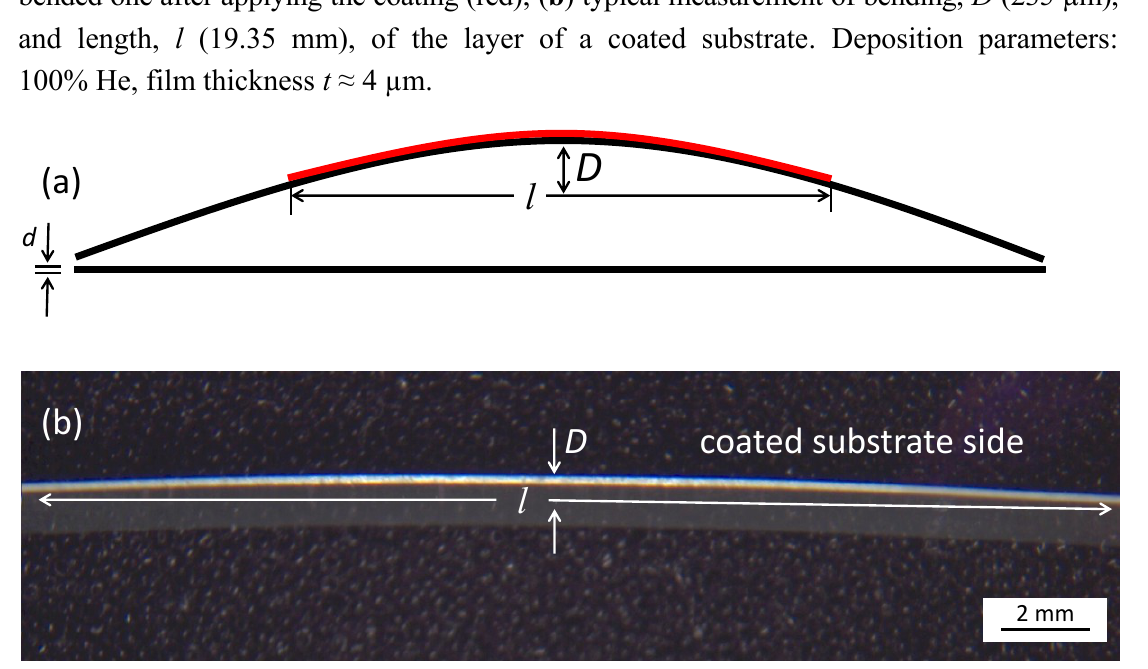
O substrate without coating and of the 2 3